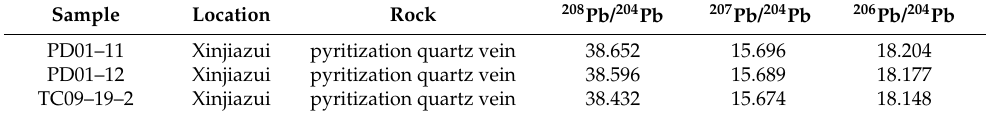
Table 3. Lead isotopic compositions of stage II pyrite (Py2) from the Xinjiazui gold deposit.